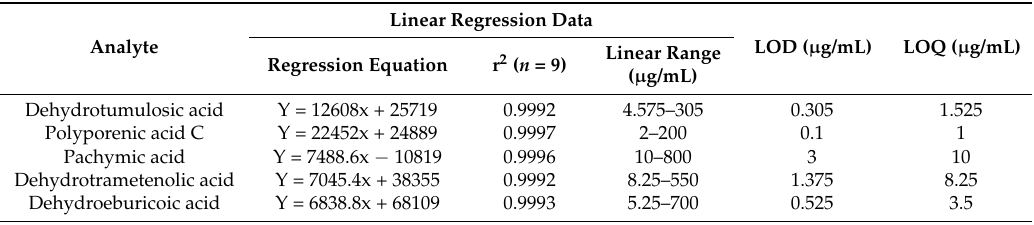
Table 1. Linear range, regression equation, LOD, and LOQ for the five investigated triterpenoids by reverse phase HPLC-UV/Vis